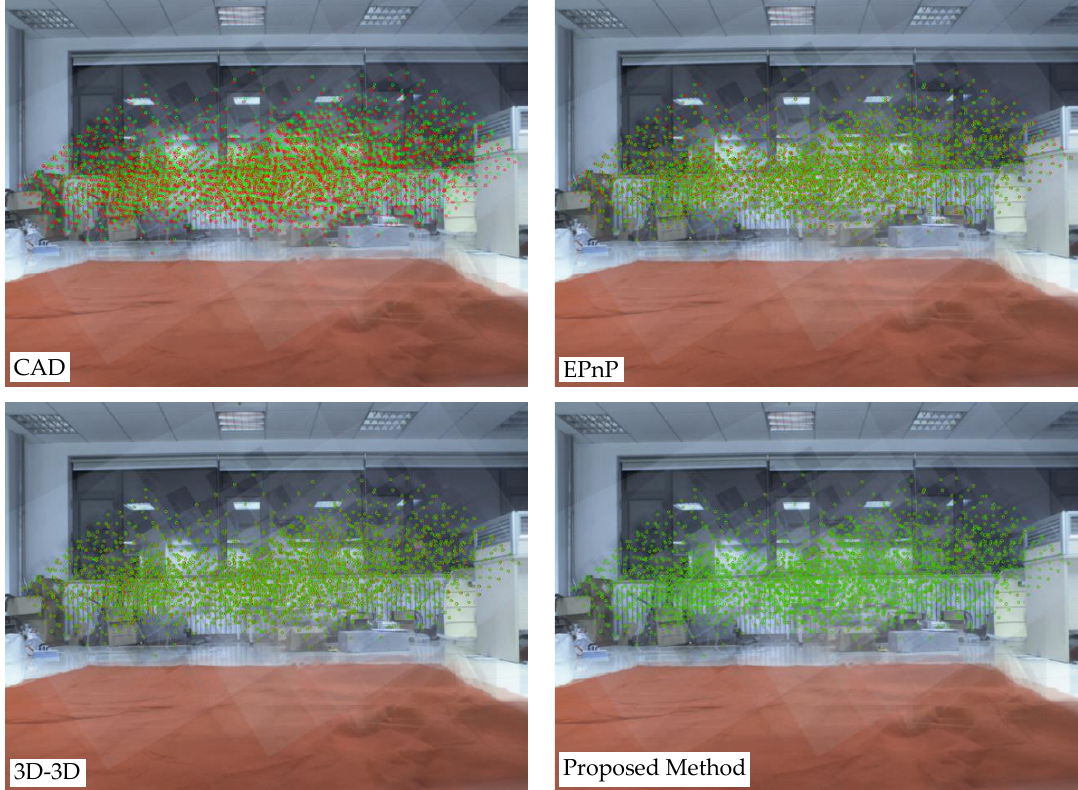
Figure 13. Visual representation of the re-projection error of different methods. Red represents re-projection feature points; green represents feature point pixels.